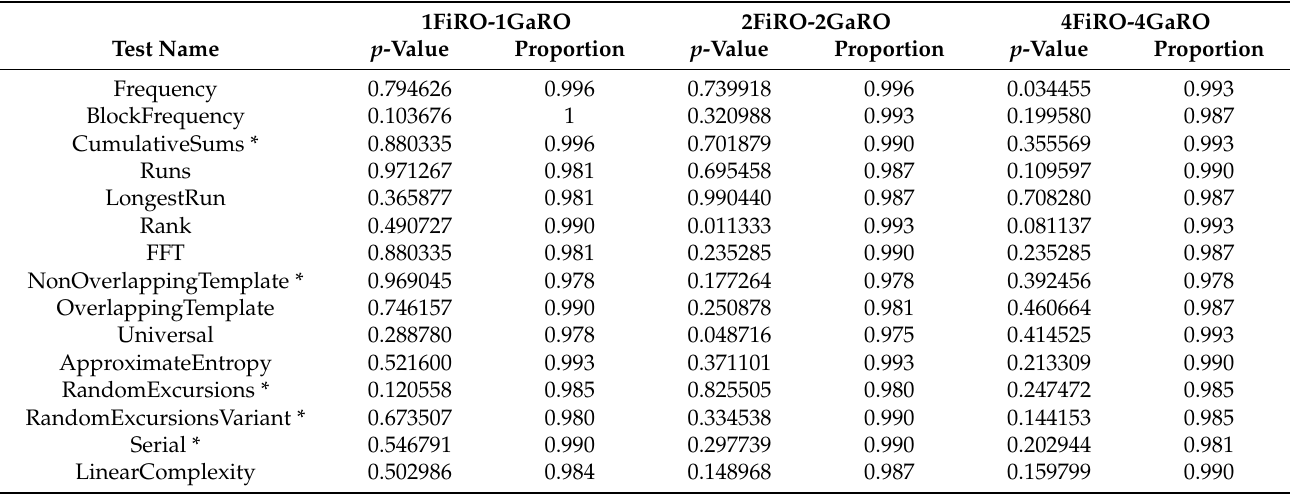
Table 7. NIST 800.22 Statistical Test Result with 100 MHz of Sampling Rate. * Worst case reported for tests with multiple outcomes. 1FiRO-1GaRO 2FiRO-2GaRO